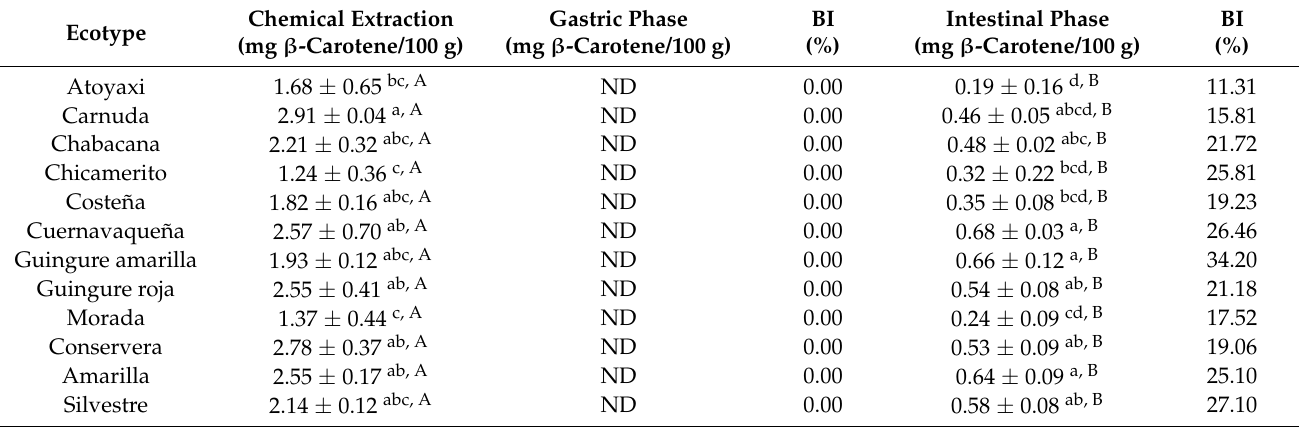
ND: Not detected. Values are expressed as the mean ± standard deviation. Different lowercase letters per column indicate a significant statistical difference ( p ≤ 0.05). Different capital letters per row a indicate significant statistical difference ( p ≤ 0.05). BI: bioaccessibility